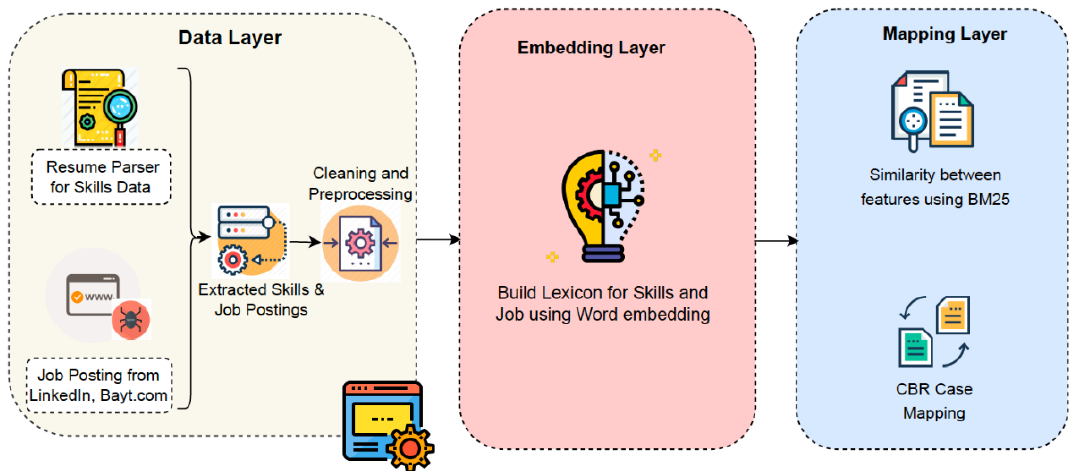
Figure 1. Methodological framework: data layer, word embedding layer, and mapping layer.